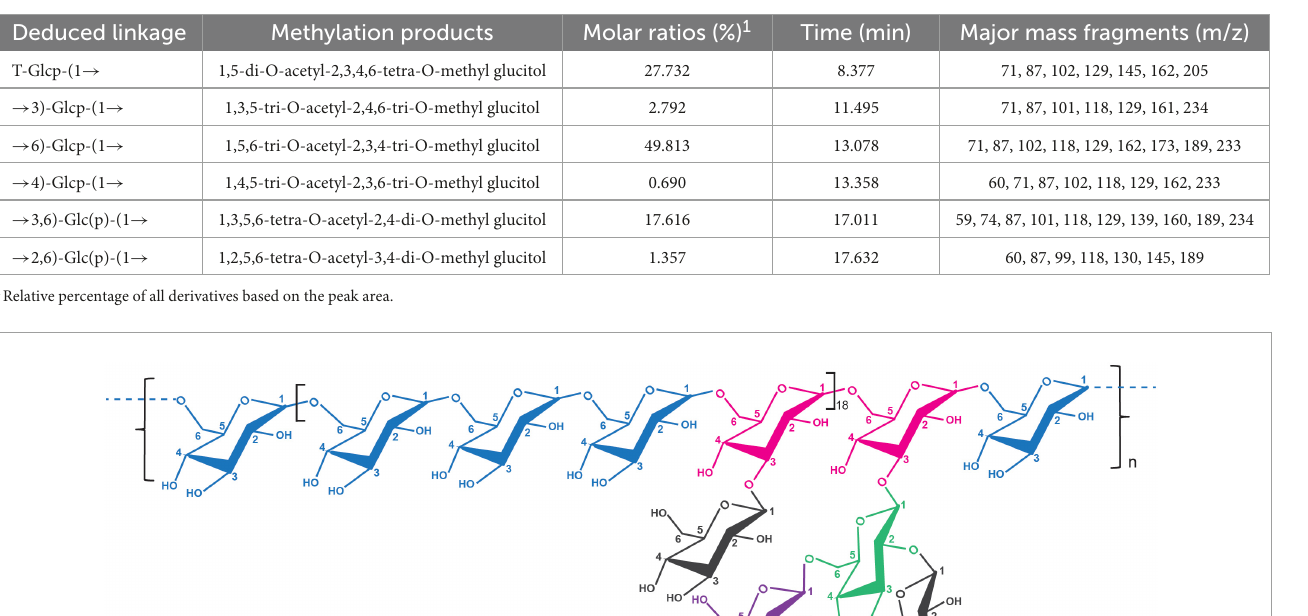
TABLE 1 Methylation analysis of RSG7 exopolysaccharide (EPS).